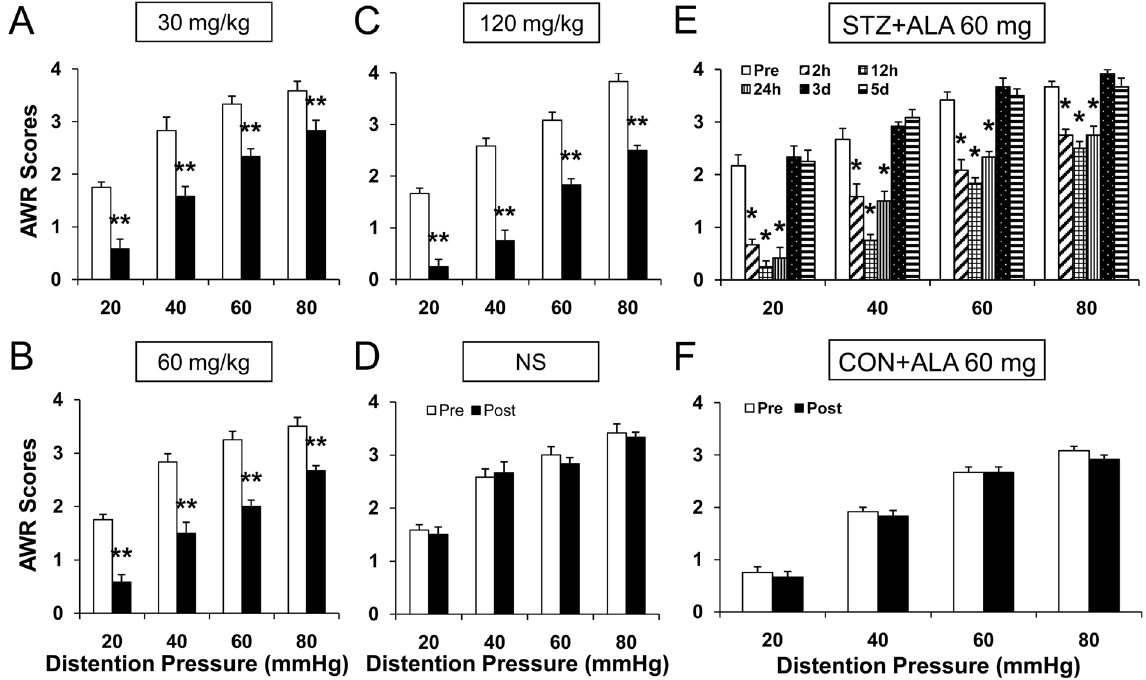
Figure 4. Attenuated colonic hypersensitivity after ALA treatment in diabetic rats. (A–C) Treatment with ALA at doses of 30, 60 or 120 mg/kg significantly resulted in a dramatic decrease in the AWR in diabetic rats (n = 6 for each group, ** p < 0.01, compared with Pre, Friedman ANOVA). (D) NS didn’t change the AWR scores of diabetic rats (n = 6 for each group, p > 0.05, compared with Pre, Friedman ANOVA). (E) Time course of ALA induced analgesic effect. ALA at 60 mg/kg significantly increased the AWR scores at 2 hours and lasted for ~24 hours (n = 6 for each group, * p < 0.05, compared with Pre, two-way repeated-measures ANOVA followed by Tukey post hoc test). ( F ) ALA at 60 mg/kg had no significant effect on the AWR scores in age- and sex- matched healthy control rats (n = 6 for each group, p > 0.05, compared with Pre, Friedman